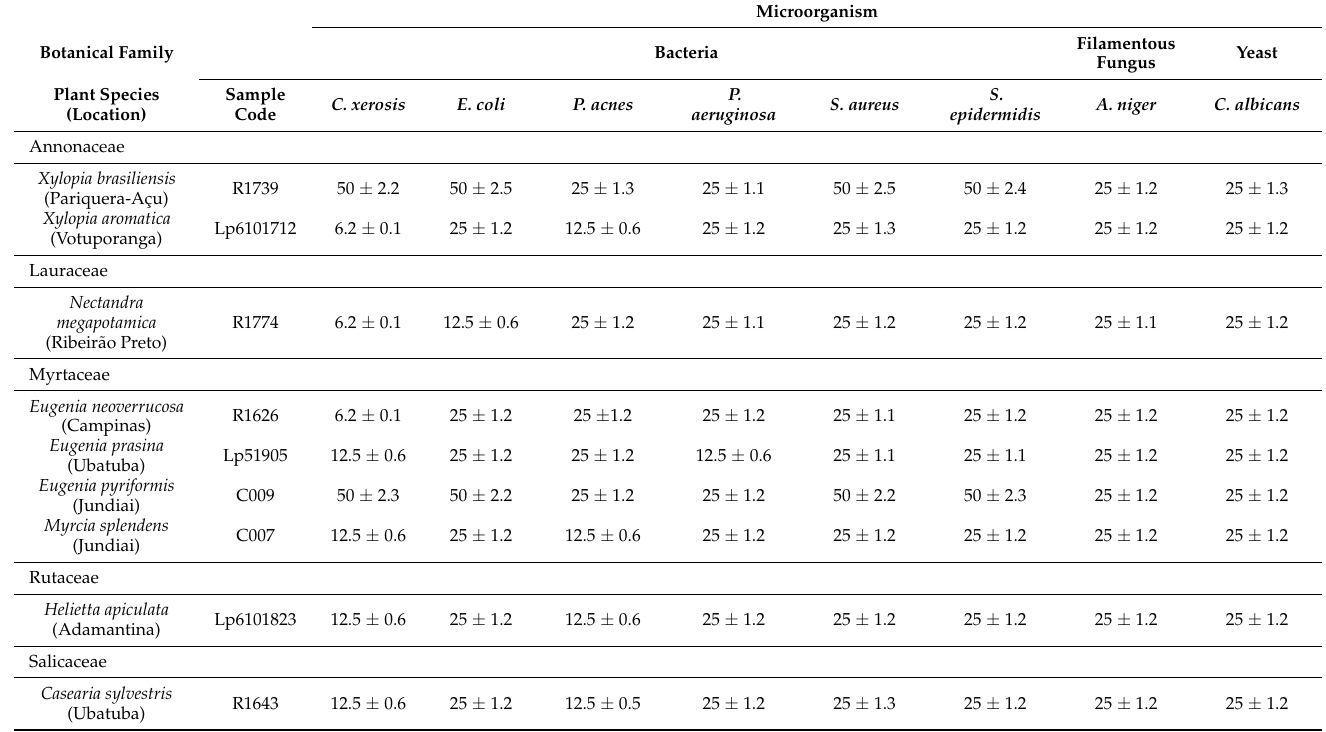
Table 2. Minimum inhibitory concentrations (MIC) of selected EOs. Growth inhibition is presented in µ g mL − 1 in comparison to normalized positive and negative controls plus/minus standard